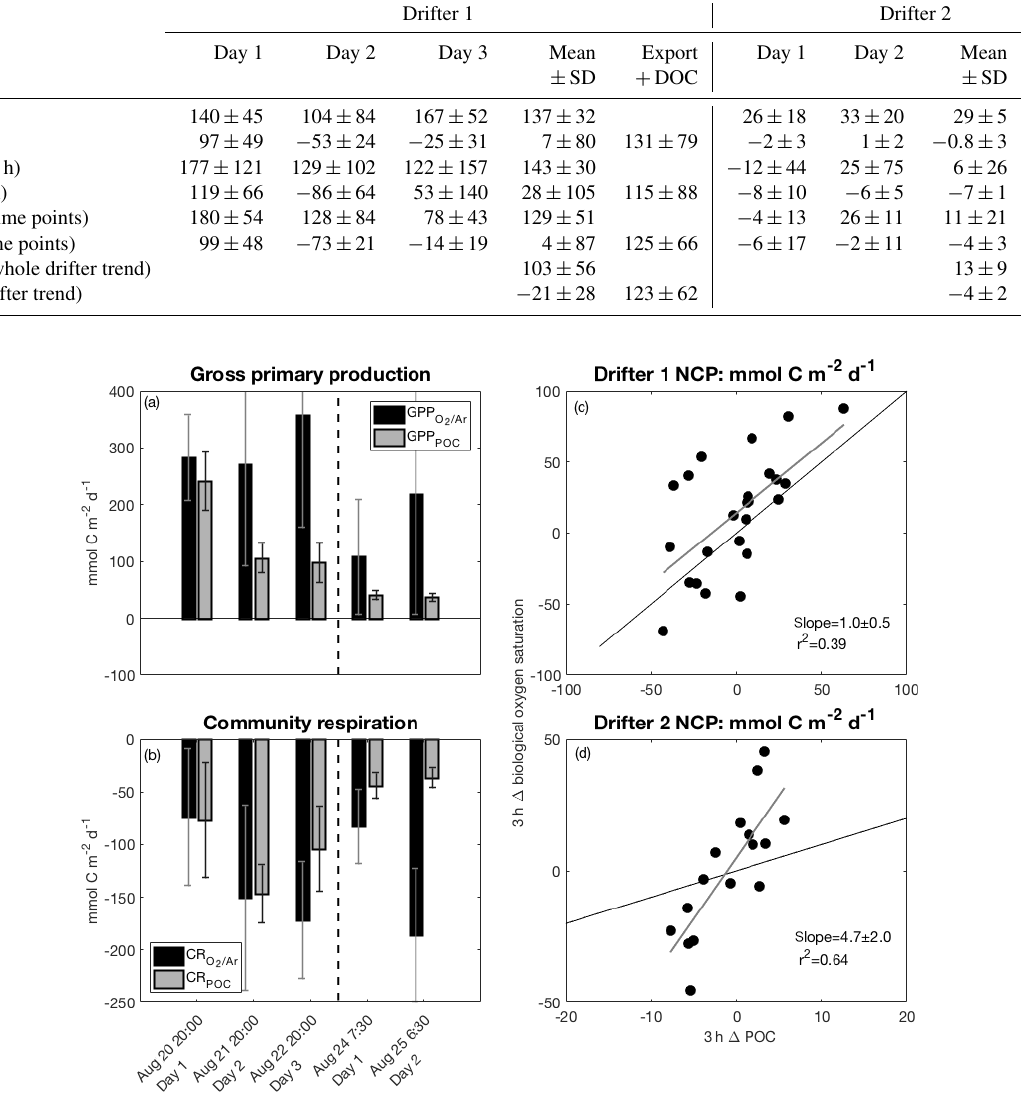
Figure 5. The left panels show comparisons between (cid:49) O 2 / Ar-derived and POC-derived (a) GPP and (b) CR over the five days of both drifter ) as a function of POC-derived NCP (NCP POC ) over 3h increments deployments. The right panels show (cid:49) O 2 / Ar-derived NCP (NCP O 2 / Ar during (c) drifter period 1 and (d) drifter period 2. The vertical dashed lines in (a) and (b) indicate the break between drifter periods 1 and 2. Thin black lines in (c) and (d) represent the 1:1 line, while thicker gray lines are the best fit from linear regressions and correspond to the indicated slope and r 2